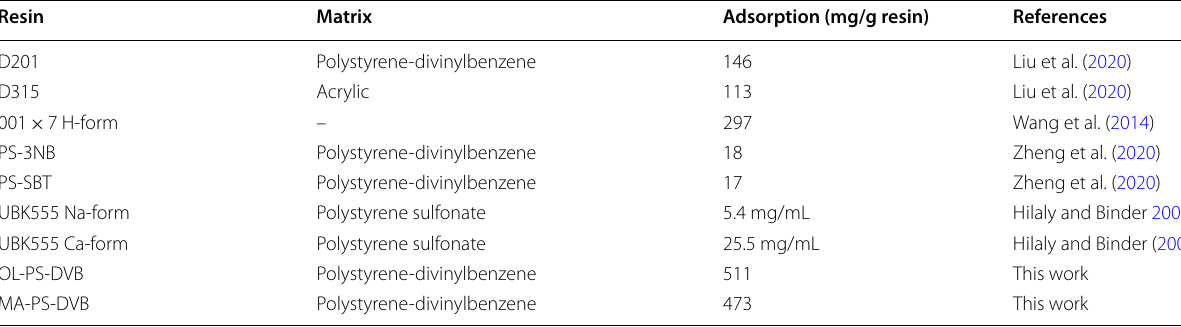
Table 1 Adsorption studies using ion‑exchange resin for 1,3‑PDO recovery